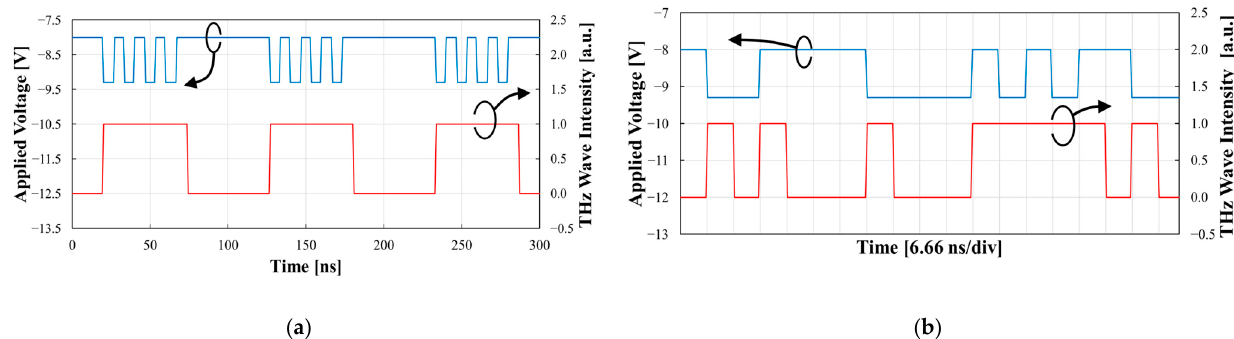
Figure 5. Designed waveform of applied voltage (upper) and expected terahertz-wave intensity (lower). ( a ) at the pattern of “0101010111111111”; ( b ) at the pattern of “1001111000010101”.